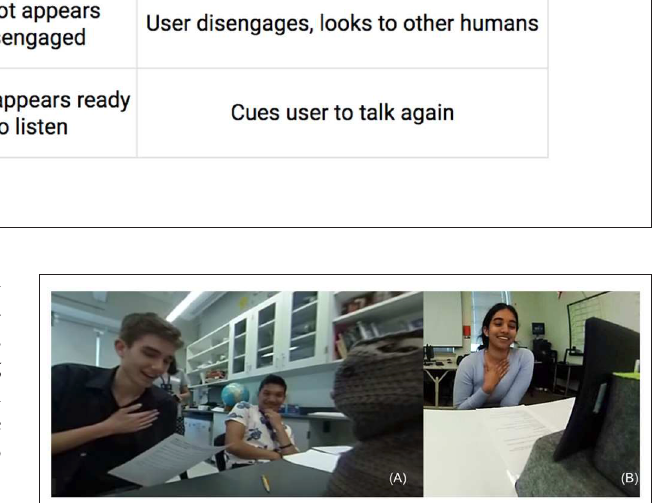
FIGURE 7 | Examples of the Heartfelt theme expressed by users during an emotional interaction with the robot. (A) Male participant interacting with Blossom. (B) Female participant interacting with